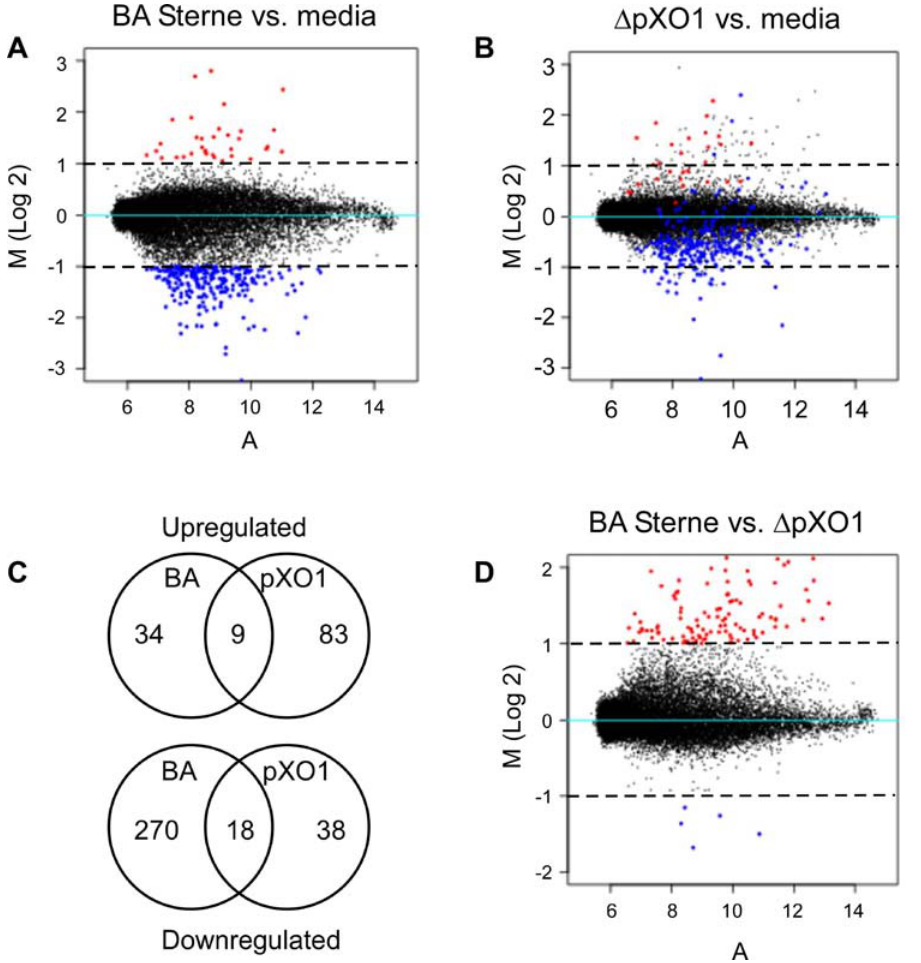
Figure 3. MA plots and Venn-diagram comparing the transcriptional response in hBMEC upon infection with B.anthracis Sterne or D pXO1 bacteria. MA plot showing the transcriptional profile of hBMEC upon infection with (A) B. anthracis Sterne vs. media control or (B) D pXO1 mutant bacteria vs. media control. Red and blue dots indicate genes that were more than two fold upregulated or downregulated, respectively upon infection with Sterne bacteria. These same genes retain their color in panel B. (C) Venn diagram depicting the number of up- or downregulated that were unique or overlapping in hBMEC upon infection with B. anthracis Sterne or D pXO1 mutant bacteria. (D) MA plot comparing gene expression of D pXO1/B.a.Sterne; red and blue dots indicate genes that were more than two fold differentially induced or suppressed,